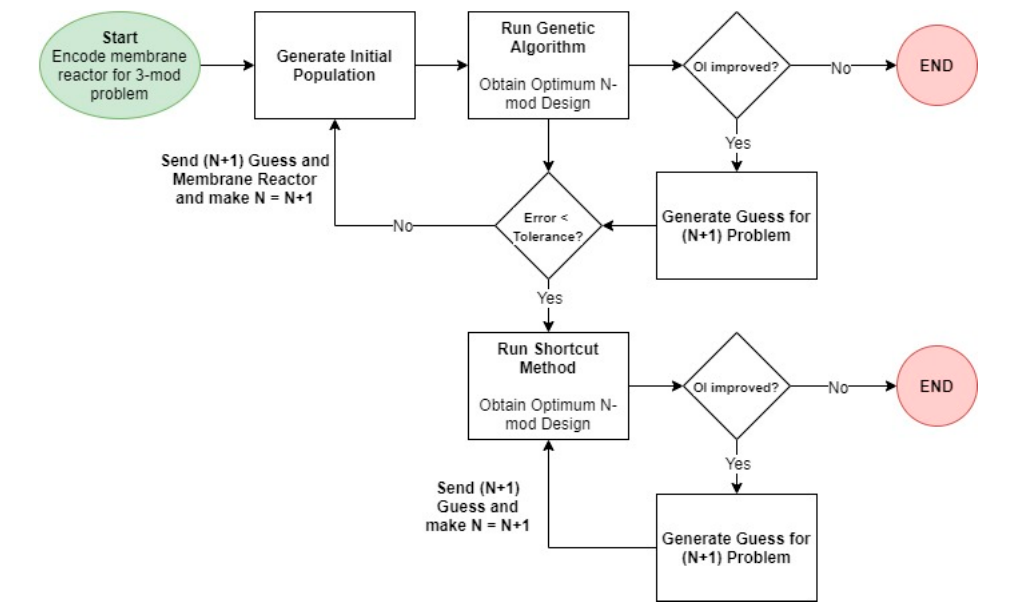
Figure 13. The proposed algorithm for the design of modular membrane systems for improved operability performance.